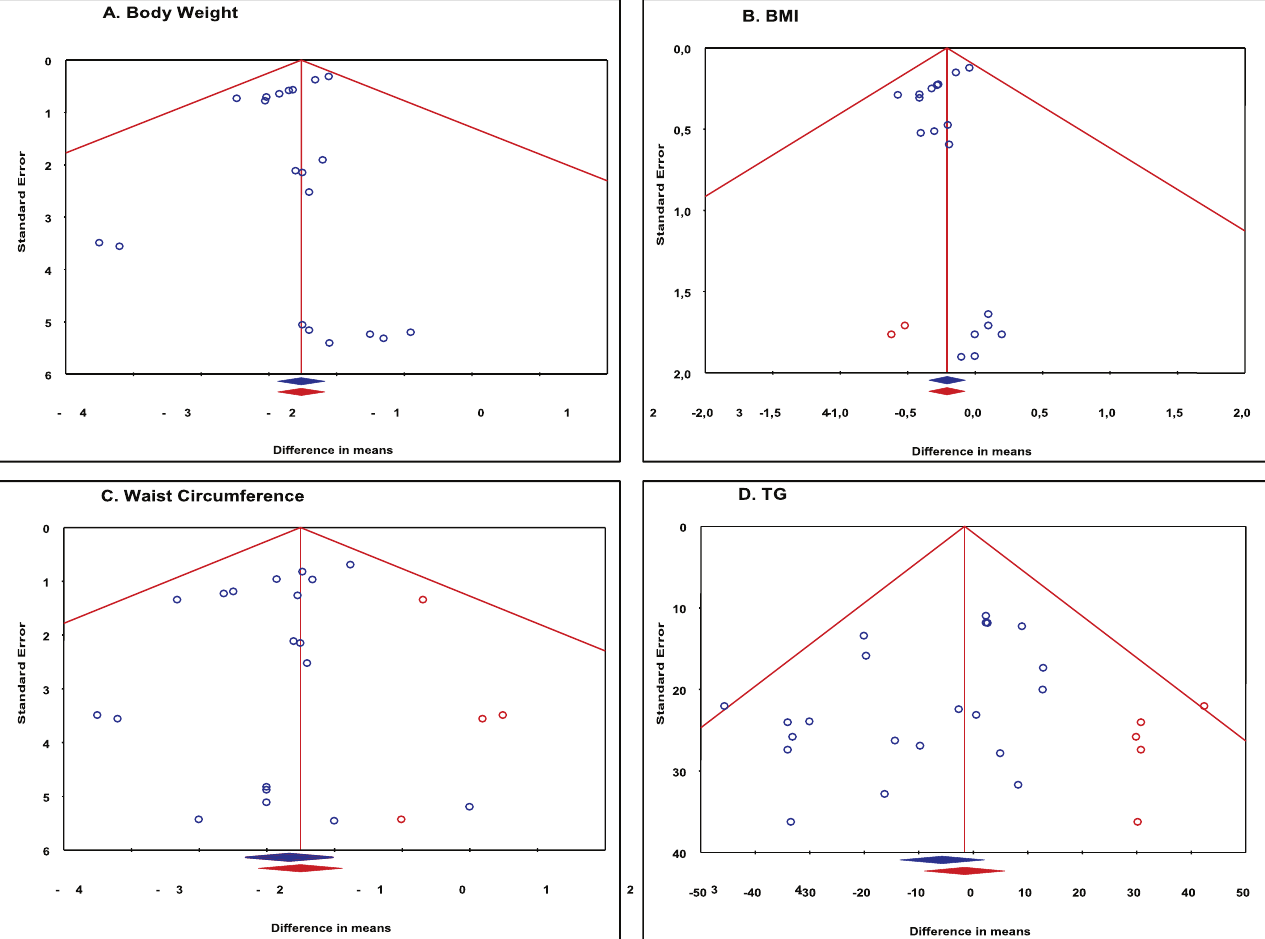
FIGURE 6 - Funnel plots of standard error by difference in means (publication bias tests) of the effects of I. paraguariensis consumption on the outcomes of this meta-analysis. BMI – body mass index; DBP – diastolic blood pressure; HDL – HDL- cholesterol; LDL – LDL-cholesterol; SBP – systolic blood pressure; TC – total cholesterol; TG –